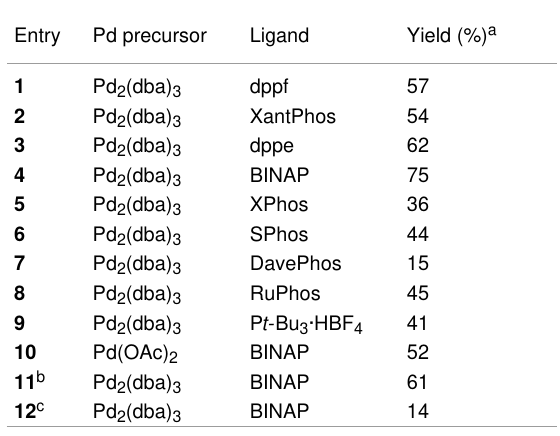
Table 1: Optimization for the Synthesis of 5b .